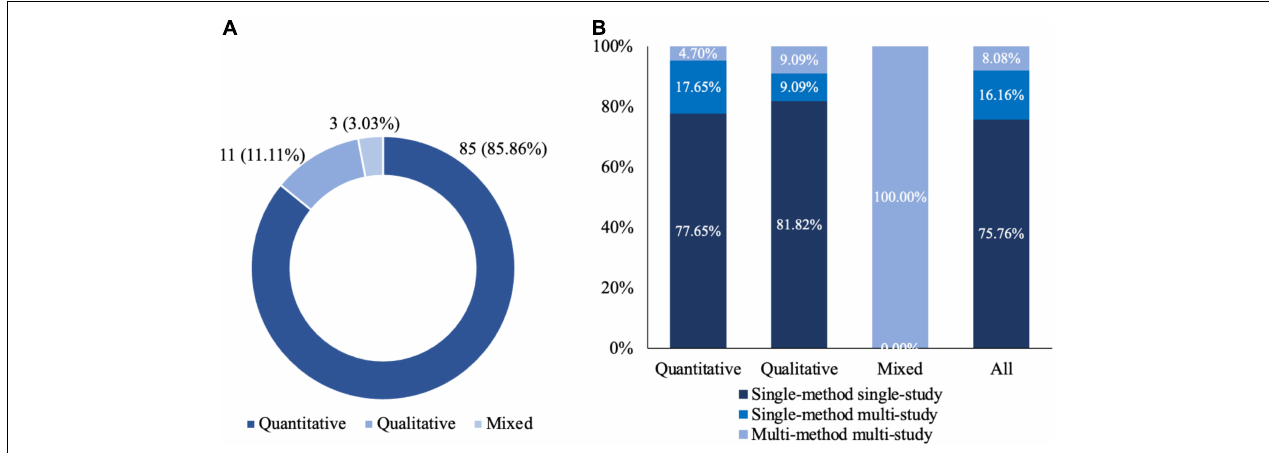
FIGURE 3 | Research design. (A) Distribution of qualitative, quantitative, and mixed studies. (B) Composition of research methodologies.